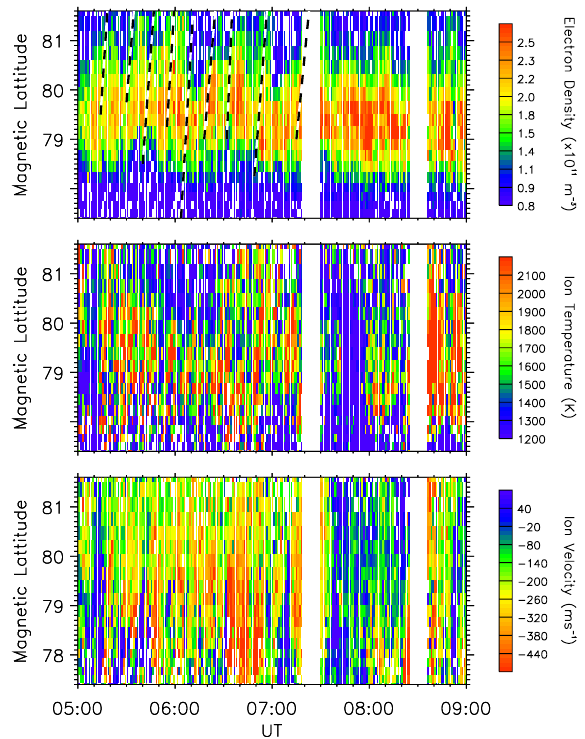
Fig. 9. Electron density, ion temperature and ion line-of-sight ve- locity measurements from low elevation northward pointing beam of the EISCAT Svalbard radar. Data are presented as a function of magnetic latitude and universal time with each parameter colour- coded according to the scales shown on the right hand side. Tran- sient features described in the text are highlighted by black and white dashed